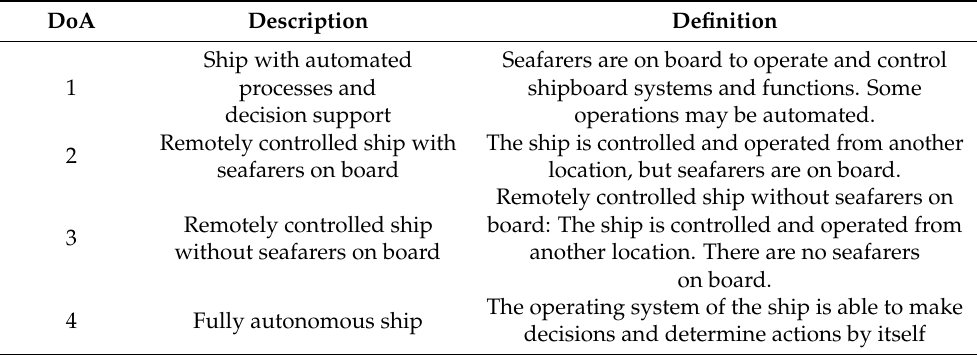
Table 1. Definitions of International Maritime Organization’s degrees of autonomy